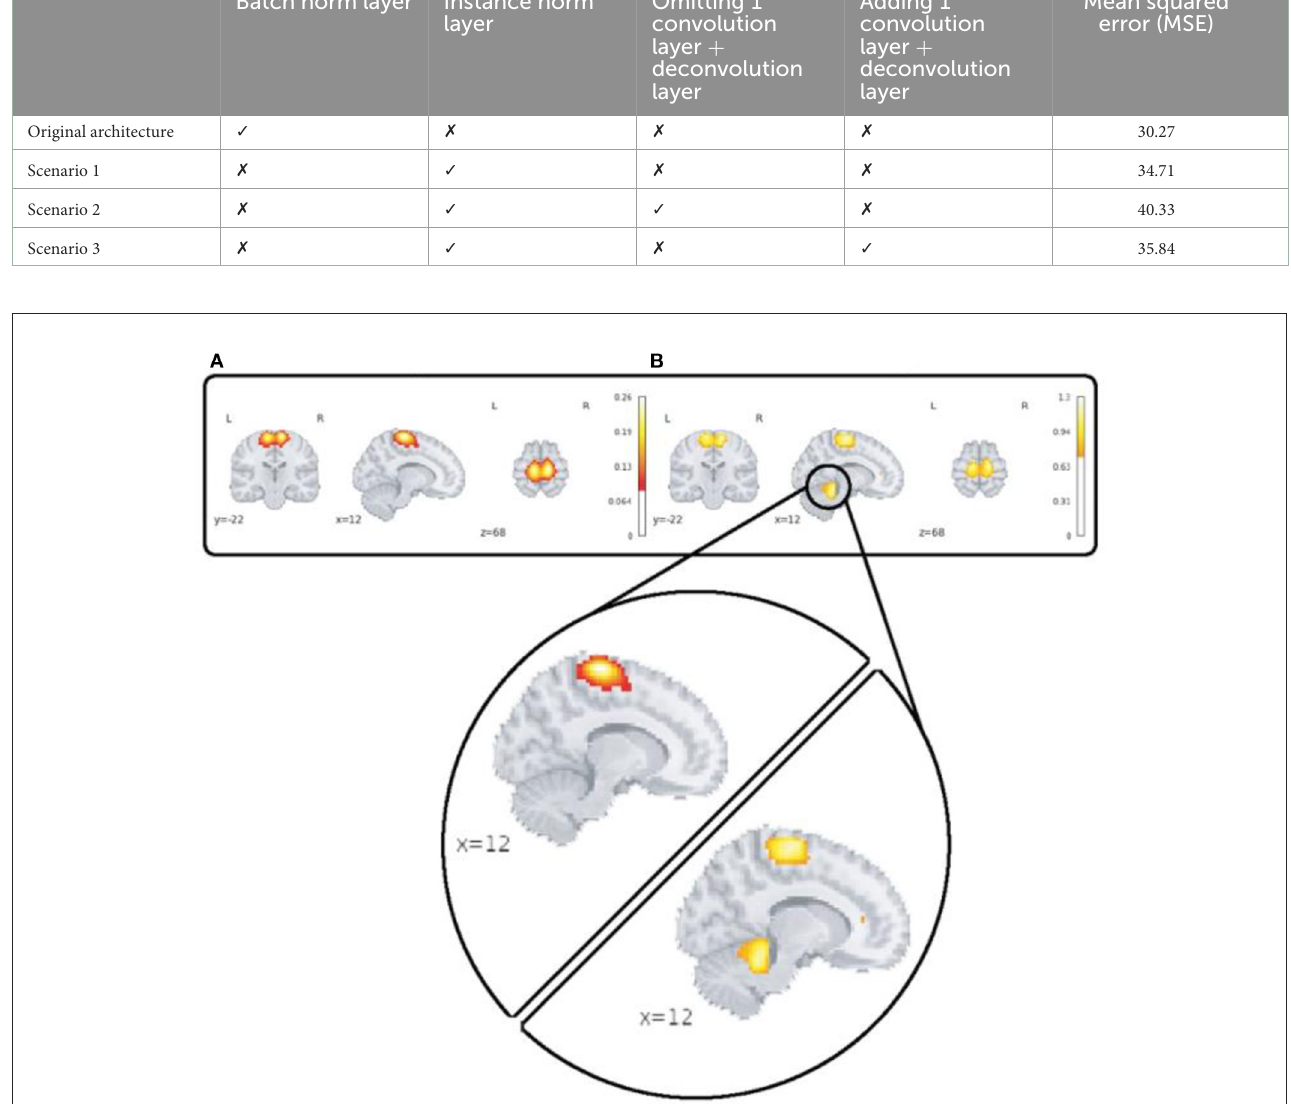
FIGURE9 This figure highlights spatial dynamics over time in a sensori-motor network (SM3) by showing a transient state from sensori-motor to cerebellar network. Part (A) shows the averaged map over time and subjects for the control group and section (B) shows spatial deviation over time which is averaged over subjects for the same